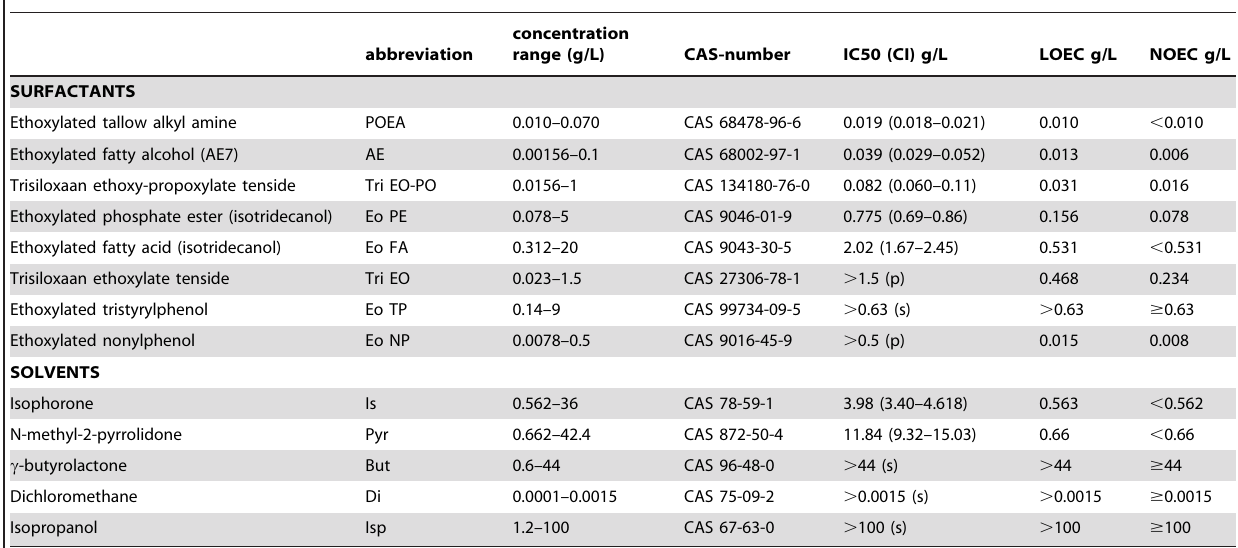
Table 2. Bacterial growth inhibition of adjuvants with used abbreviations throughout the study, concentration range tested (g/L), respective CAS number, IC50 values (concentration at which 50% of the bacteria stopped growing) with confidence intervals (CI), NOEC and LOEC (no and lowest observed effect concentration) at the growth inhibition level.